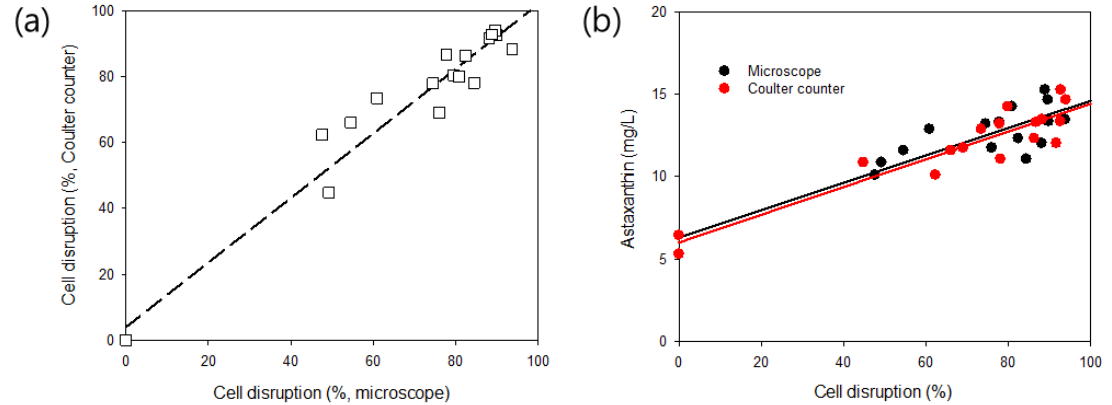
Figure 4. ( a ) Cell disruption efficiency relationship between microscopic cell typing and instrumental particle-size-distribution measurements (r 2 = 0.95); ( b ) astaxanthin recovery, depending on cell disruption efficiencies (microscope, r 2 = 0.83; Coulter counter, r 2 = 0.86).